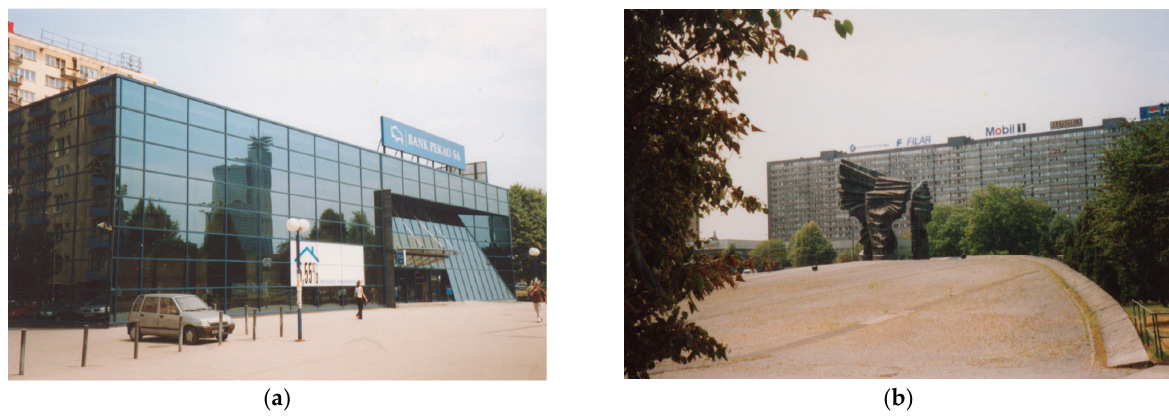
Figure 9. Objects within the impact range: ( a ) bank building with a glass elevation; ( b ) small architecture object: a monument to the Silesian Insurrections.